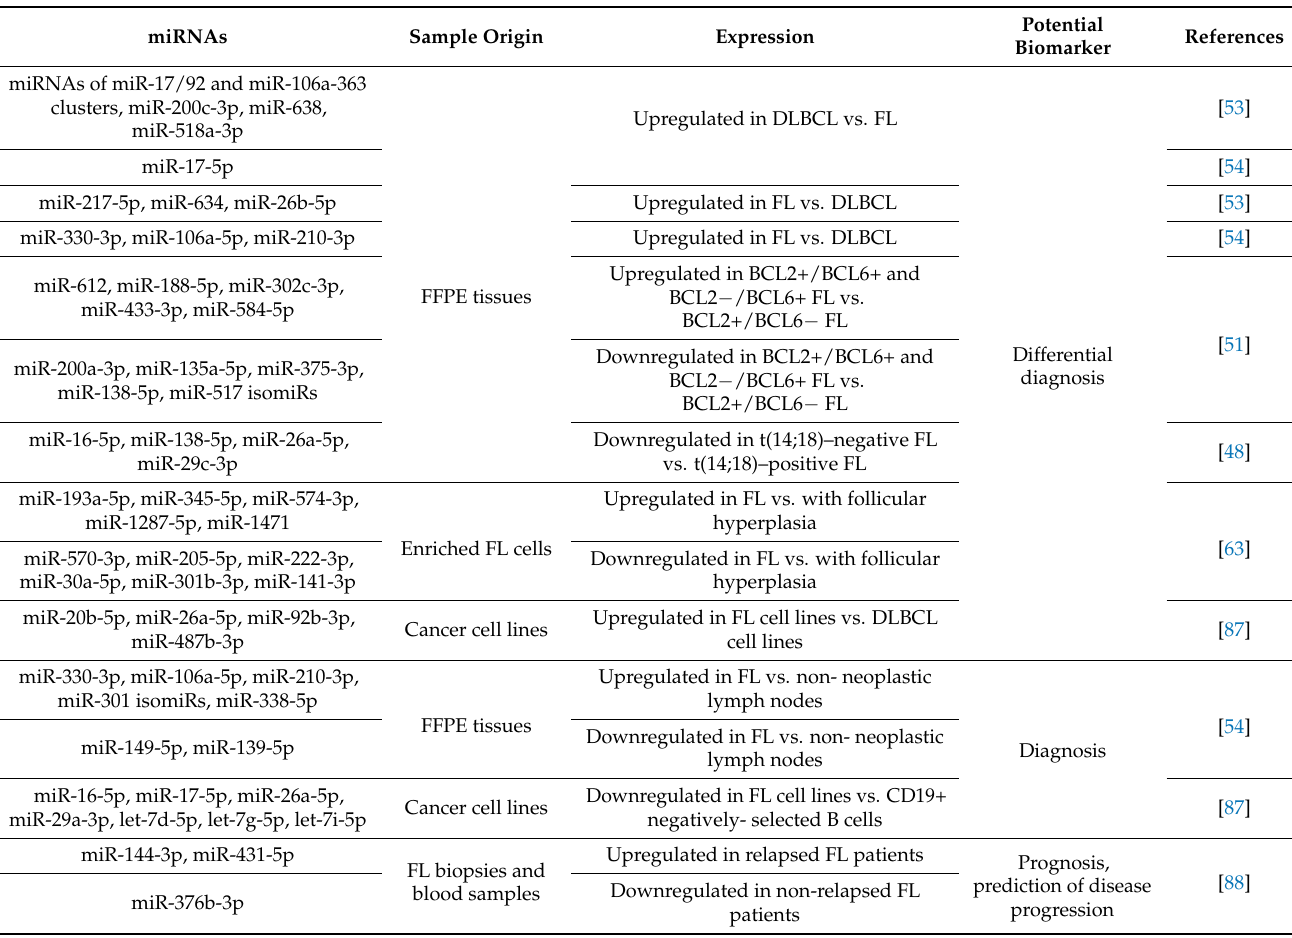
Table 2. miRNAs as candidate biomarkers in follicular lymphoma